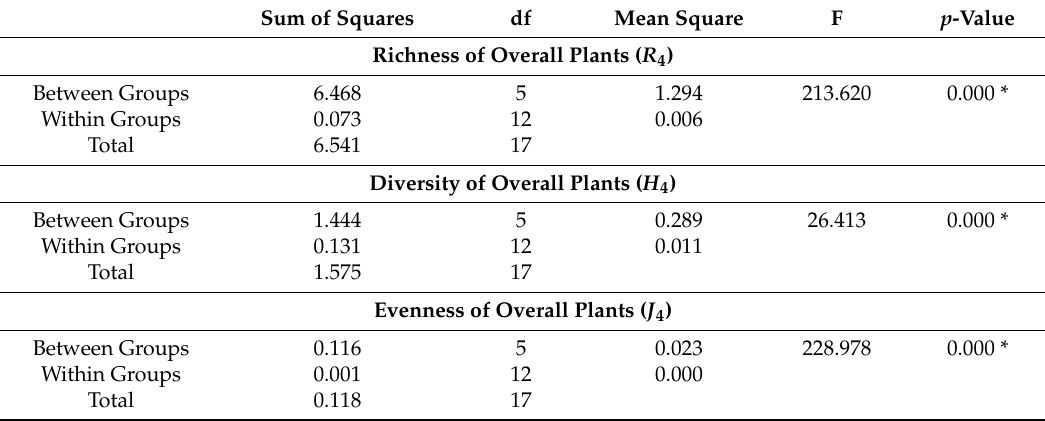
Table 6. ANOVA results on the impacts of harvesting intensity on community diversity indices.